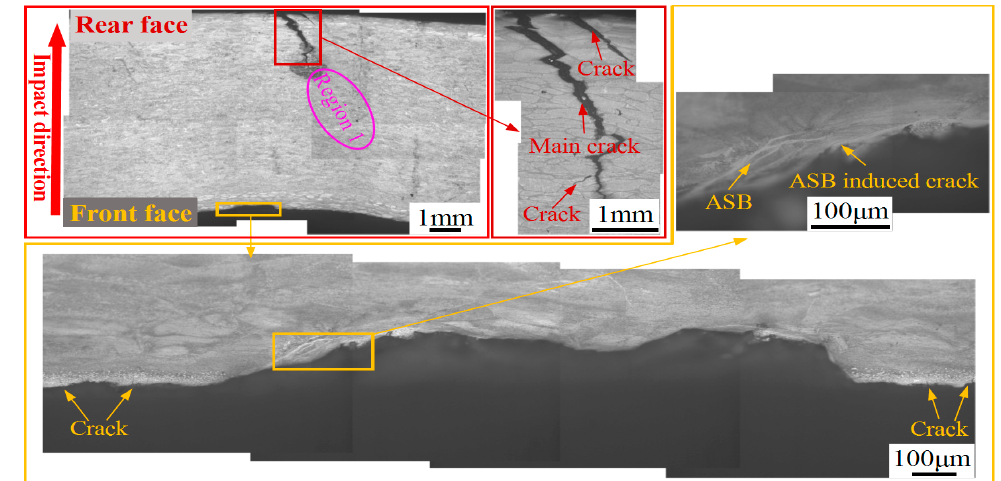
Figure 11. Optical micrographs showing the microstructure of the impact crater half-section of the hot-rolled titanium alloy plate.